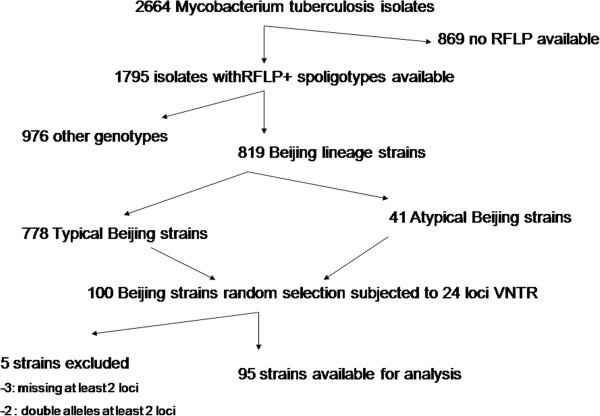
Study flow chart.